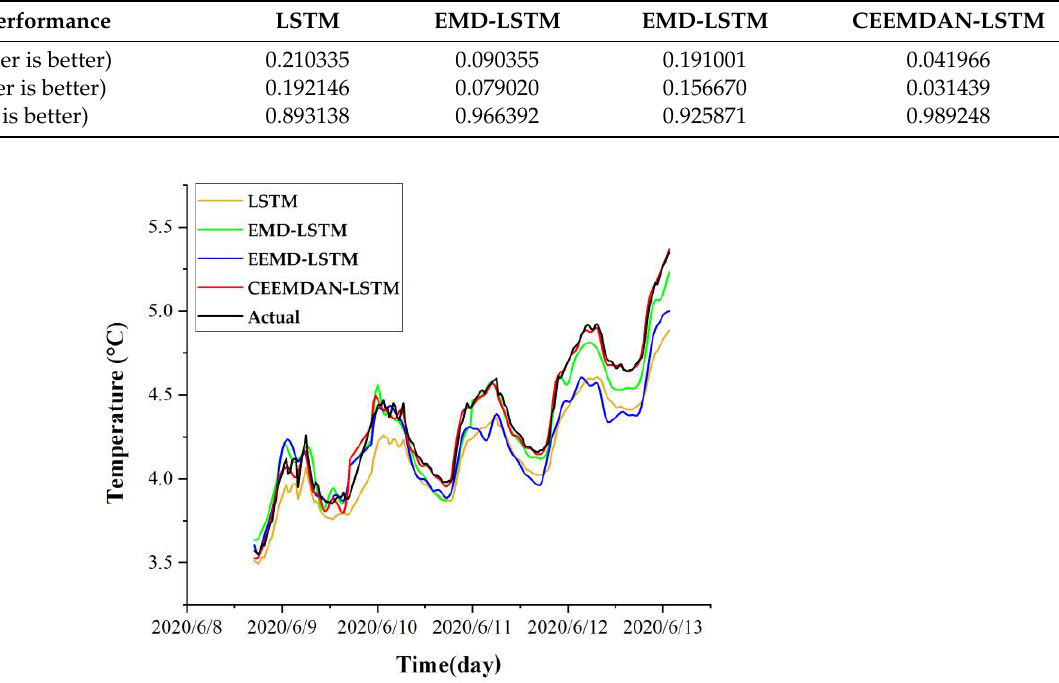
Table 1. Comparison of prediction performance of different models.